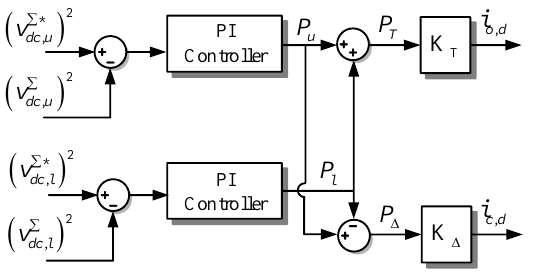
Figure 4. Direct current (DC) voltage control loops for setting the output and circulating current